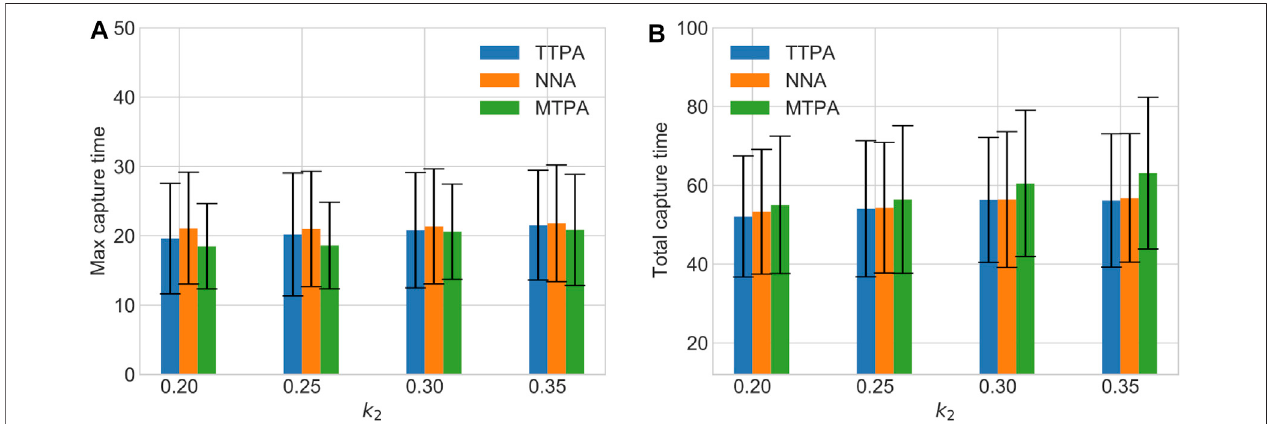
FIGURE 8 | The effect of varying measurement noise level on maximum capture time (A) and total capture time (B) .